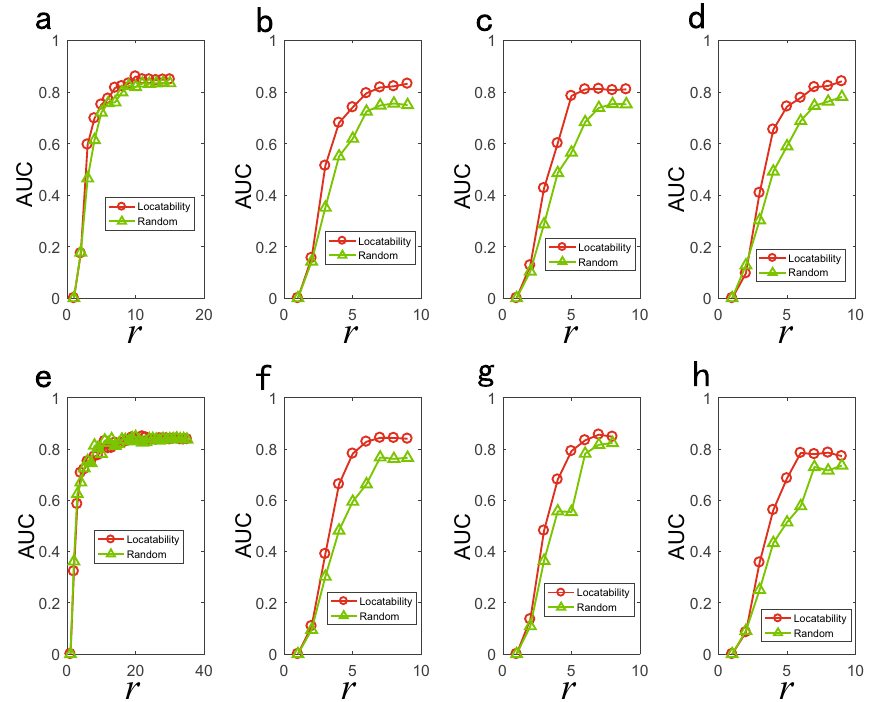
Figure 11. Locating source results of locatability and random strategy of SI dynamics on model networks. Abscissa is the number of observer nodes r and ordinate is AUC value. We simulate SI epidemic on model network with 50 nodes and set (cid:31) = 0.5 and two sources. ( a )–( d ) are the results of BA networks and correspond to network average degree � k � = 2, 4, 6 and 8 respectively. ( e )–( h ) are the results of ER networks and correspond to adding link probabilities 0.05, 0.25, 0.45 and 0.65